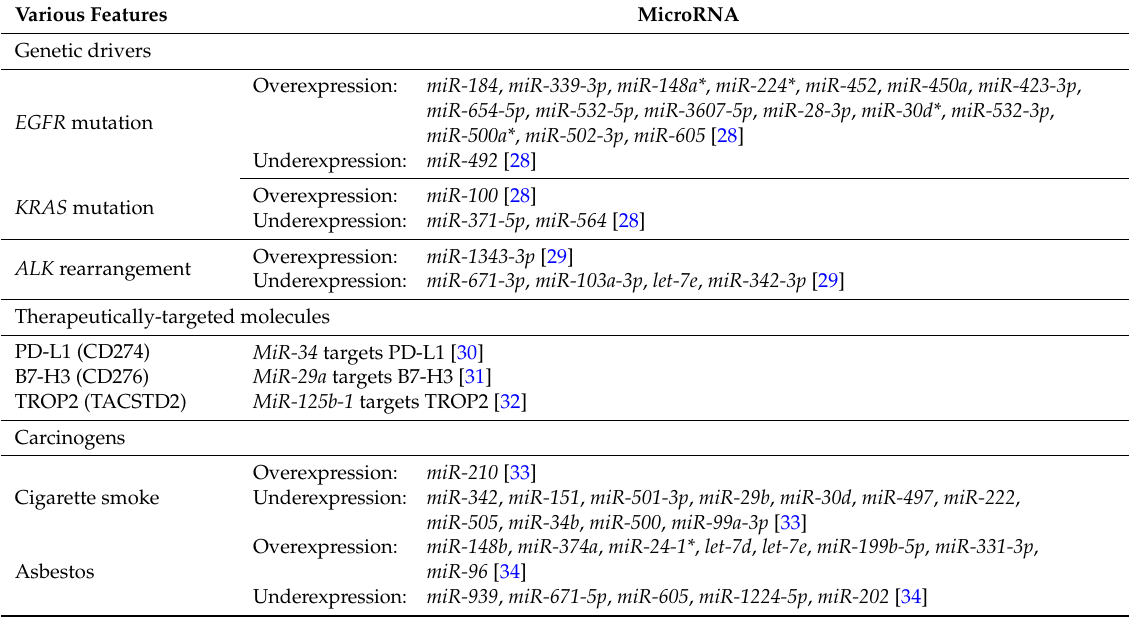
Table 1. Association of microRNAs with genetic drivers, therapeutically-targeted molecules, and